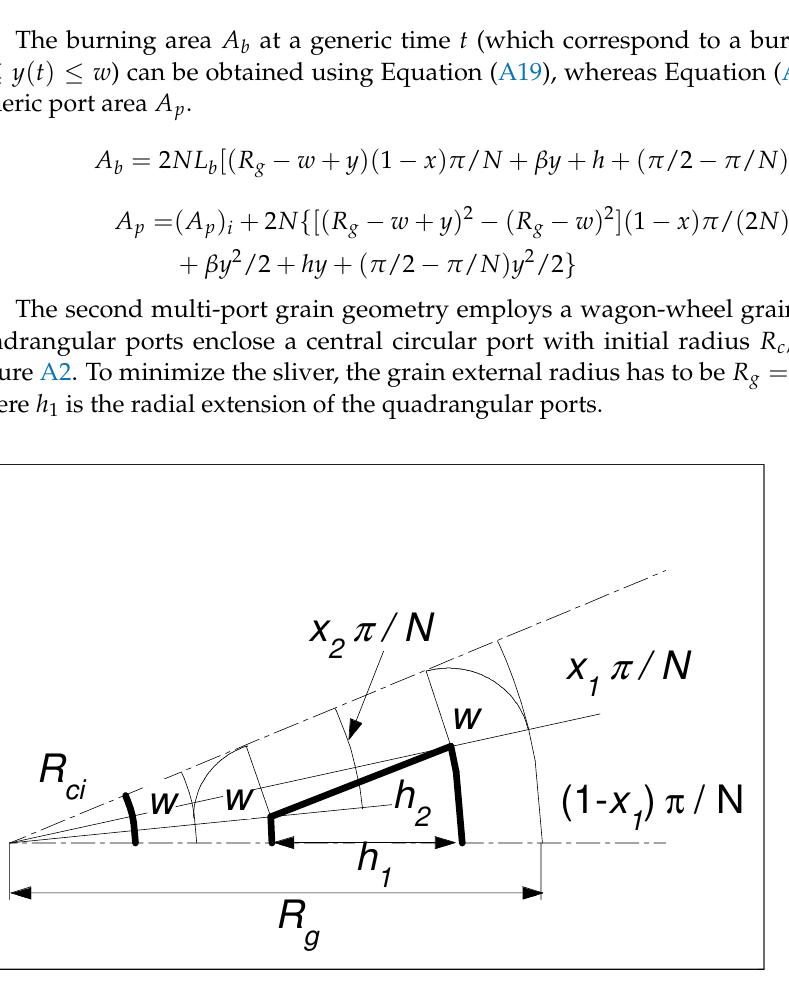
Figure A2. Quadrangular port